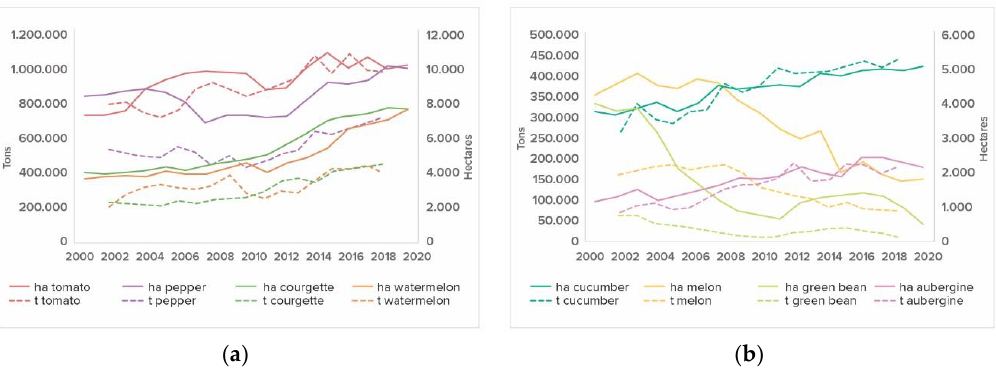
Figure 4. Evolution of land area and crop production: ( a ) Tomato, watermelon, pepper and courgette crops; ( b ) aubergine, green bean, cucumber and melon crops. Source: Authors’ own elaboration based on data from the Ministry of Livestock, Fisheries and Sustainable Development of the Regional Government of Andalusia.